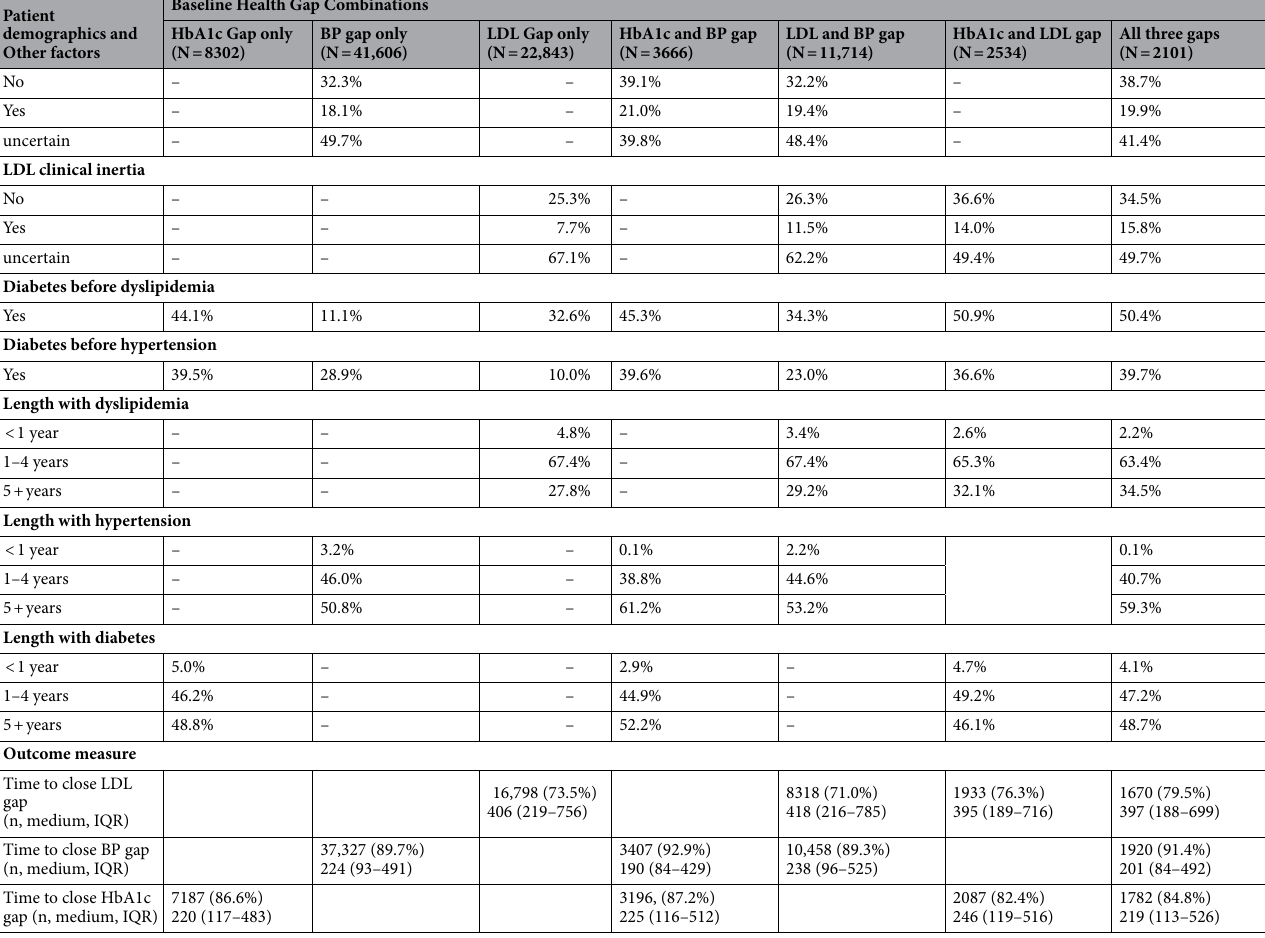
Table 2. Baseline Characteristics for patients with at least one biometric health gap at baseline, stratified by number and types of health gaps at